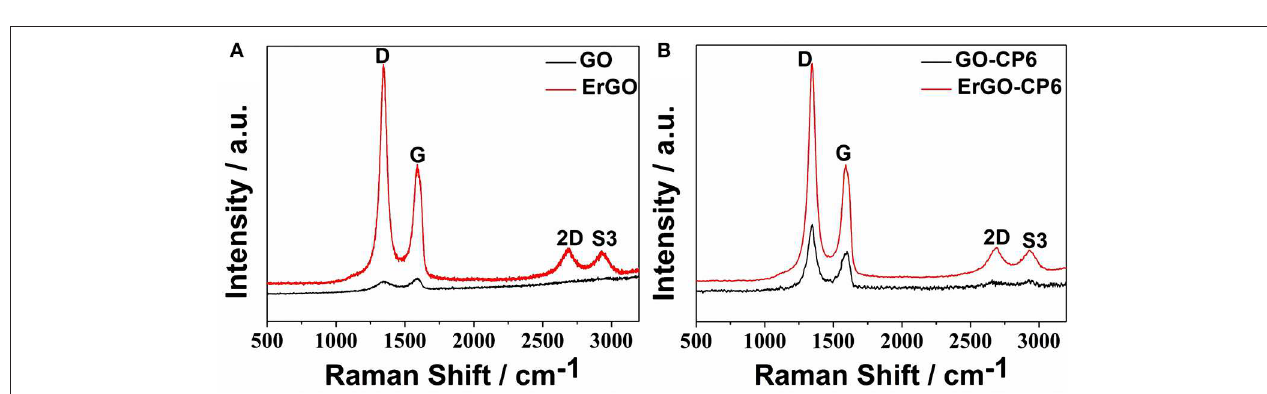
FIGURE 4 | (A) Raman spectra of GO and ErGO; (B) Raman spectra of GO-CP6 and ErGO-CP6.